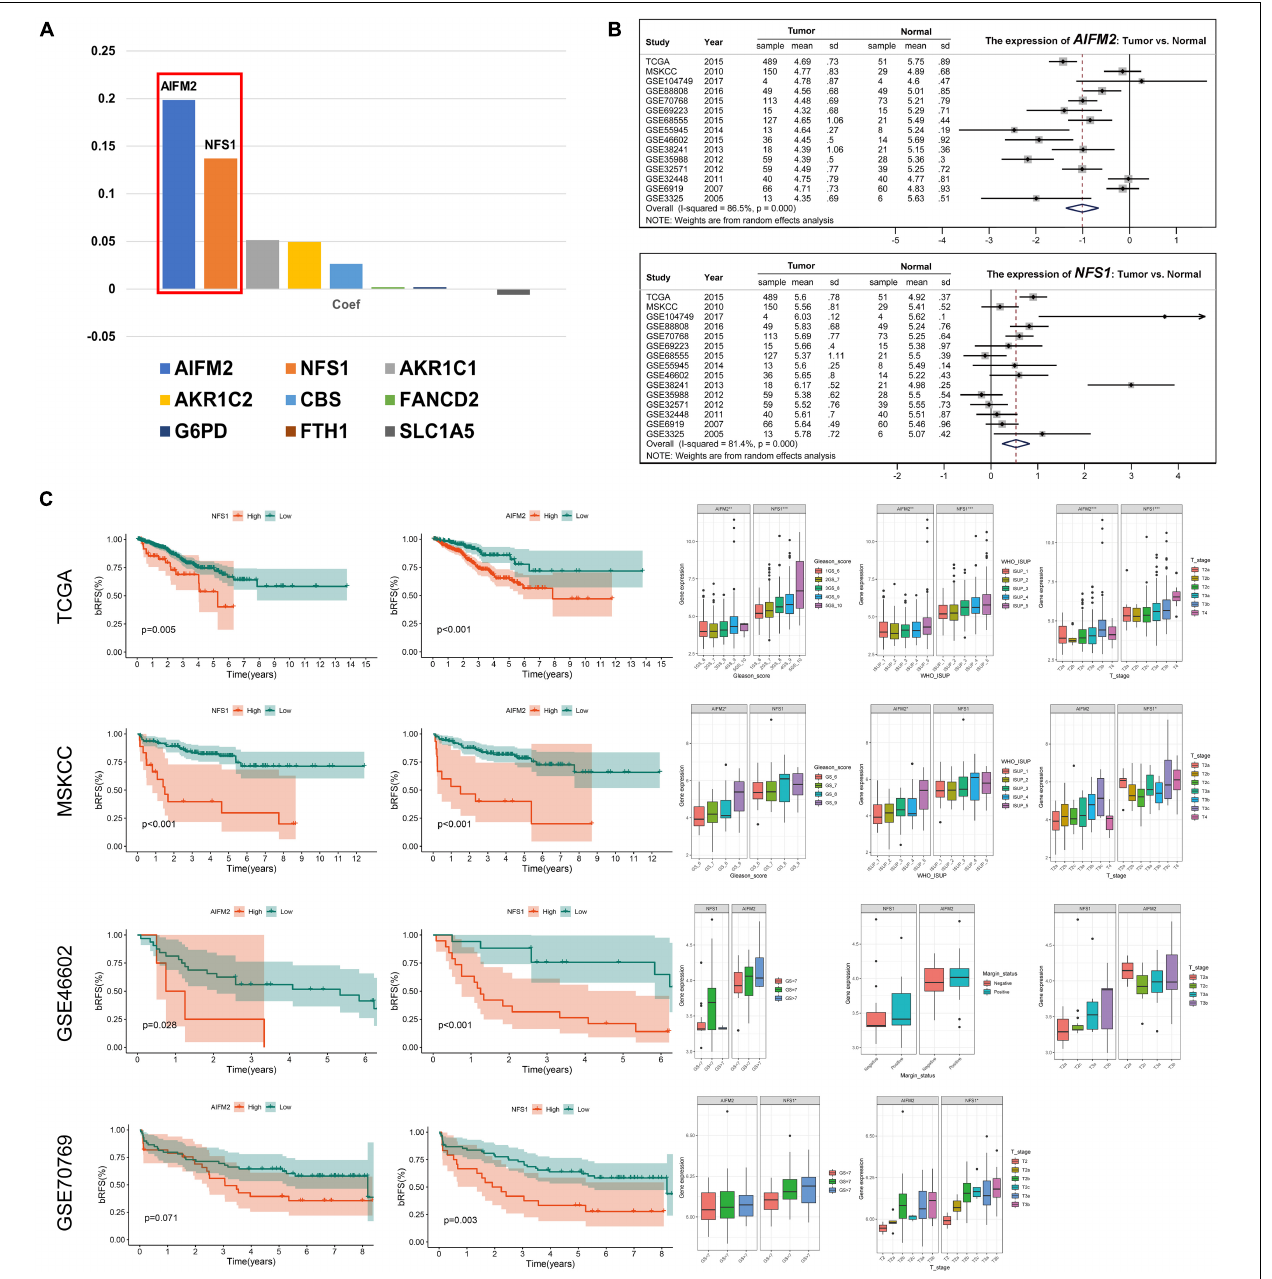
FIGURE 11 | AIFM2 and NFS1 were differentially expressed in PCa tissues and were associated with poor outcome. (A) The weight coefficient of each component in the signature. (B) The differential expression of AIFM2 and NFS1 in tumor and normal tissues based on multiple datasets. (C) AIFM2 and NFS1 were significantly associated with prognosis based on multiple datasets (* p < 0.05; ** p < 0.01; *** p <